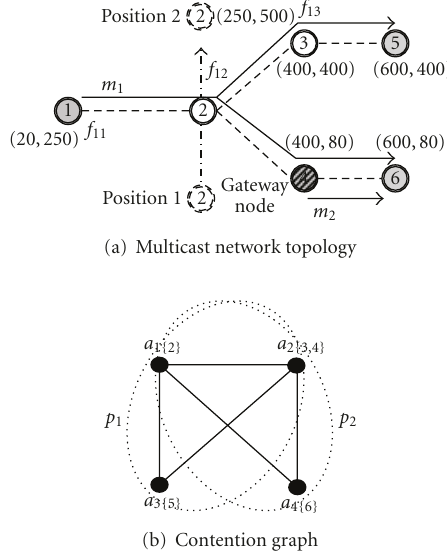
Figure 8: E ff ect of changing di ff erentiation gains on the calculated rates and aggregate